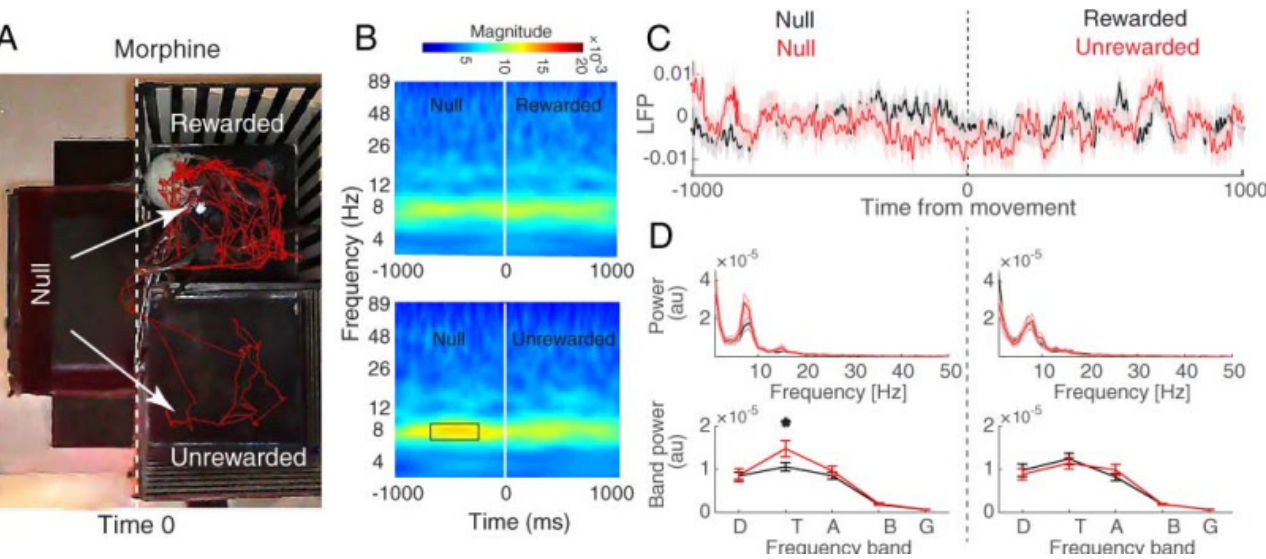
8 of 18 Figure 3. Hippocampal CA1 local field potential of the saline group. ( A ) Behavioral tracking of an ‐ imals during LFP recording in the post ‐ test session of CPP (red line), animals received saline in both rewarded and unrewarded sides. The dashed line indicates the time that the rat chooses to enter